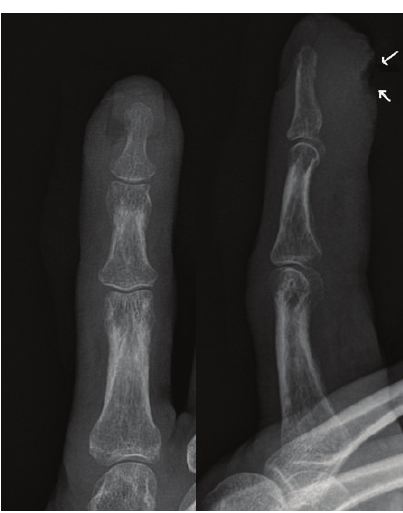
Figure 1: Preoperative anteroposterior and lateral radiographs of the index finger. Arrows: necrotic area in the soft tissues.